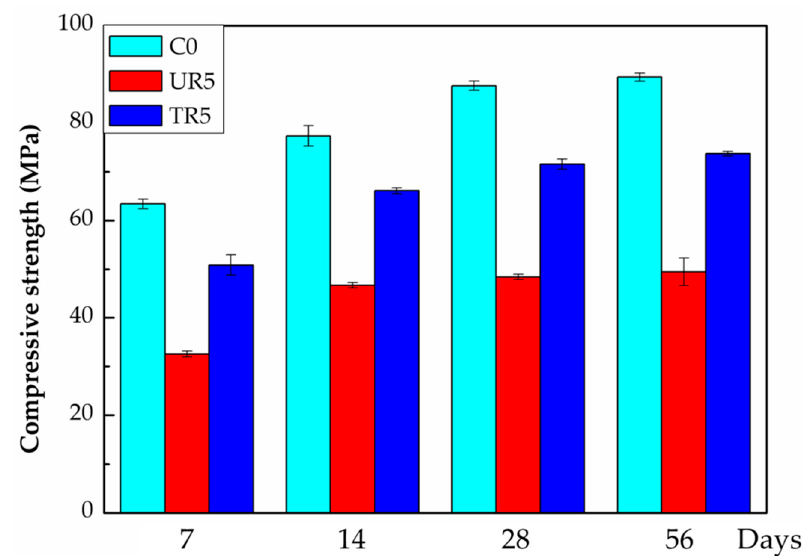
Figure 12. Compressive strength of hardened paste. Where C0: pure cement, UR5: with 5% as-received crumb rubber, TR5: with 5% treated crumb rubber [34,35].